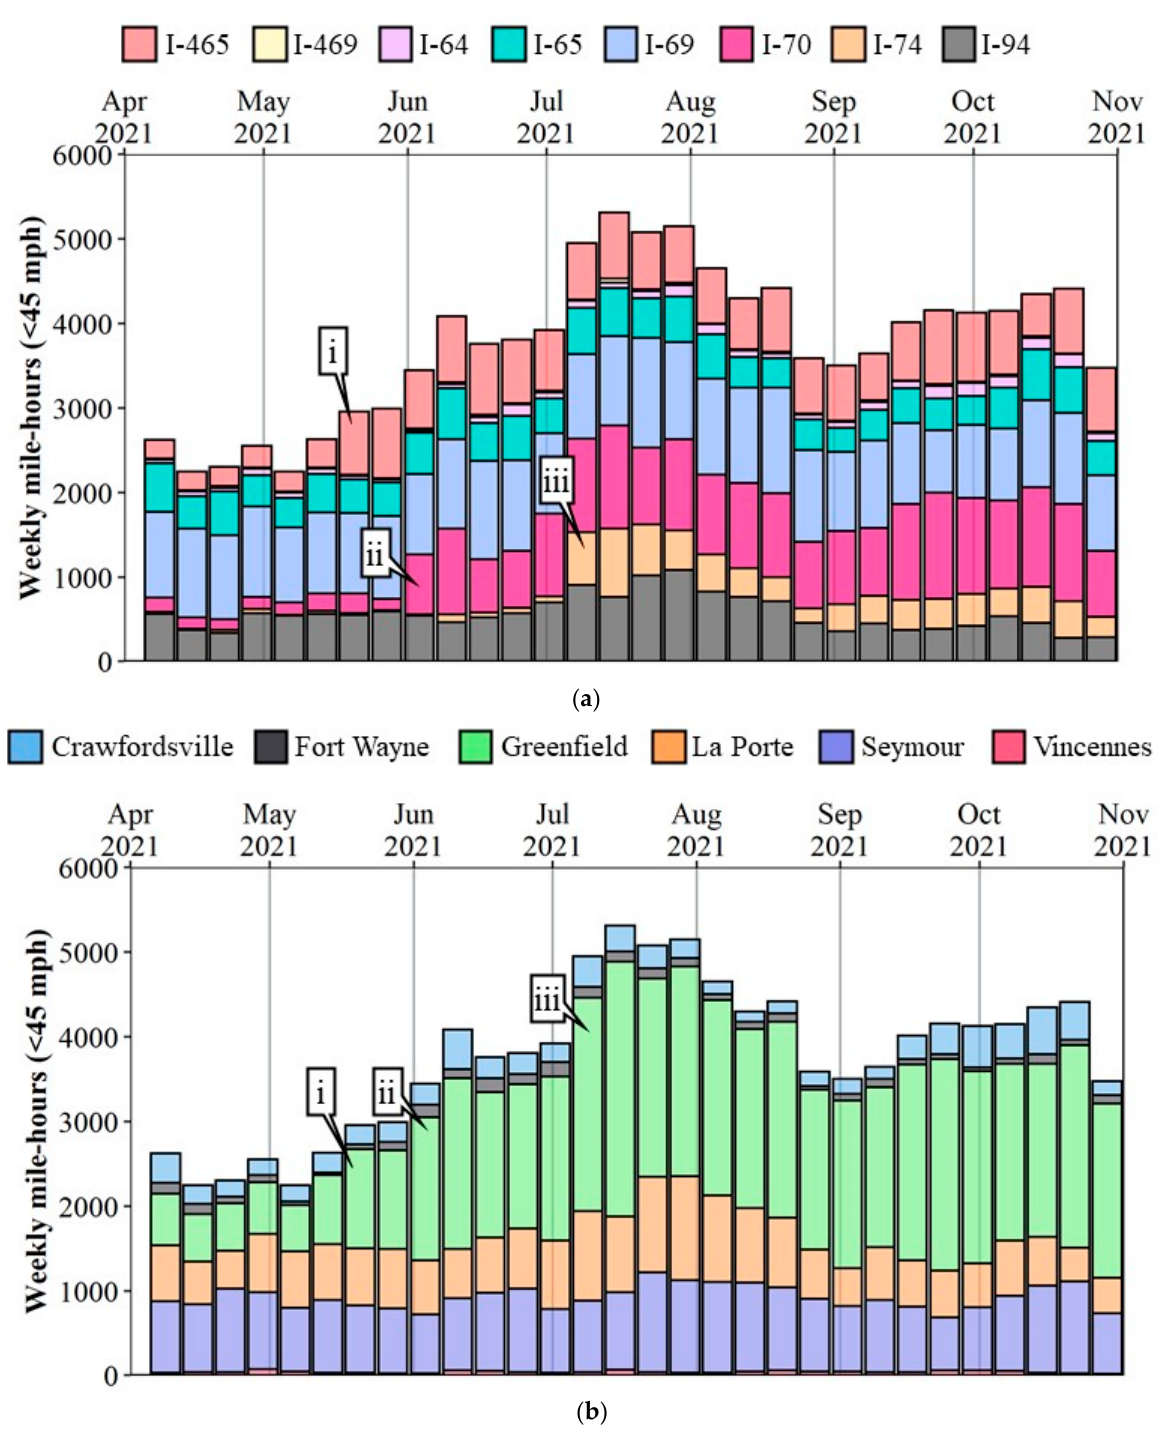
Figure 4. Mile–hours of congestion (< 45 mph) during the 2021 construction season. ( a ) Mile–hours of congestion by Interstates; ( b ) Mile–hours of congestion by INDOT districts.